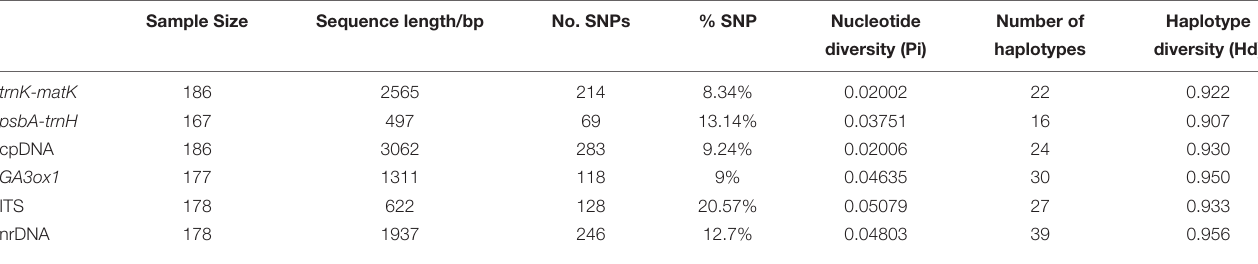
TABLE 1 | The characteristics, nucleotide diversity and haplotype diversity of the four DNA markers. Sample